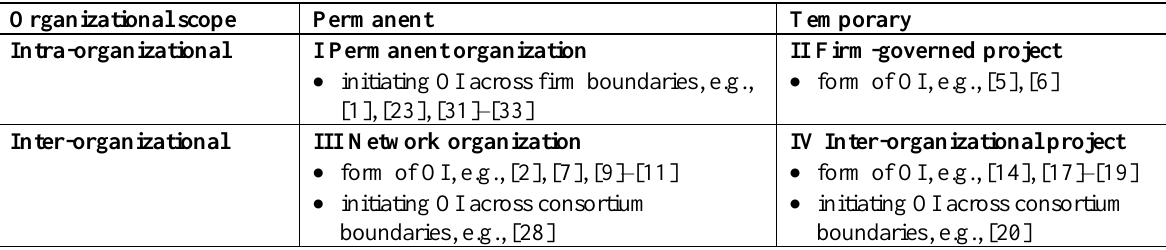
Table 1. Organizational perspectives on